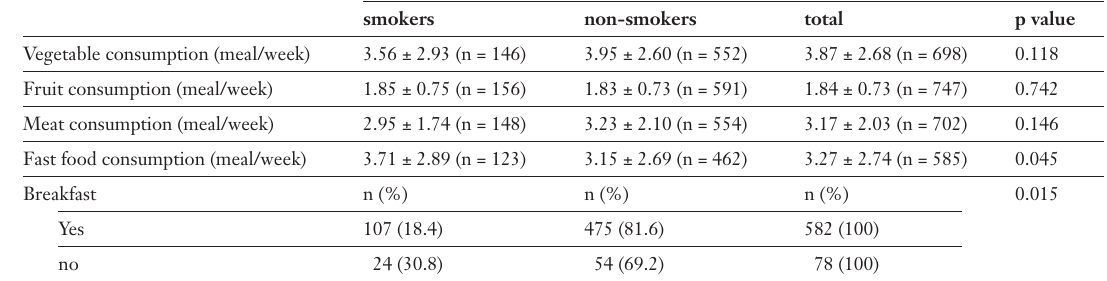
Figure 1 Age-specific smoking onset percentages.